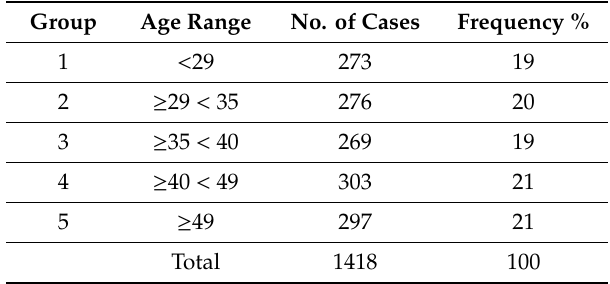
Table 2. Sample distribution by age. Source: Compiled by authors.